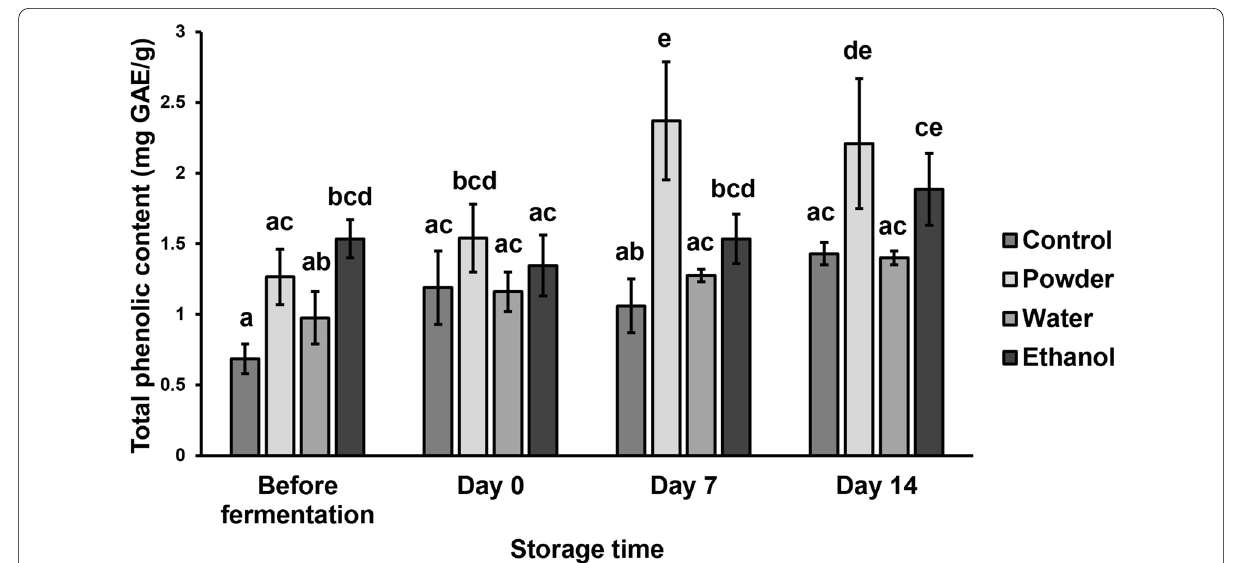
Fig. 1 Total phenolic content of yogurt samples during storage (4 °C). Bars with different letters are significantly different ( p <